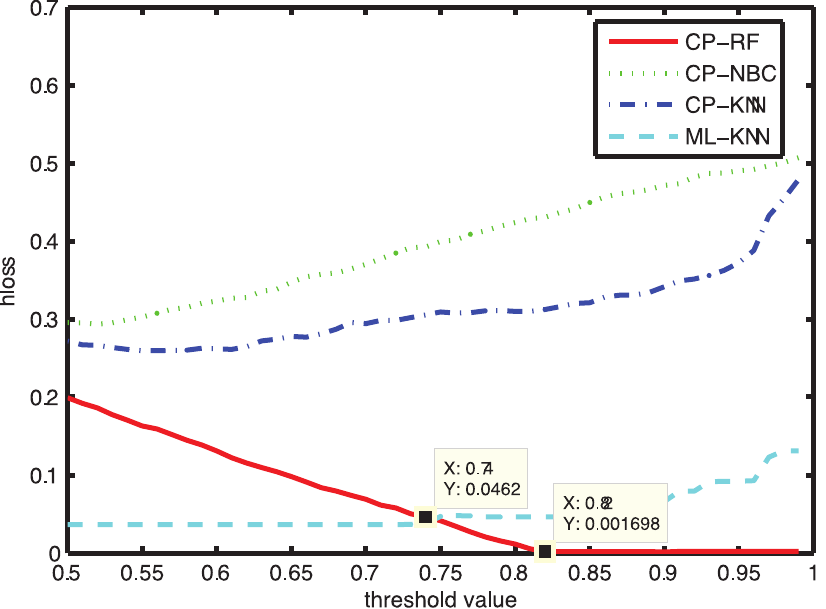
Figure 4. Comparison of hamming loss with different thresholds.